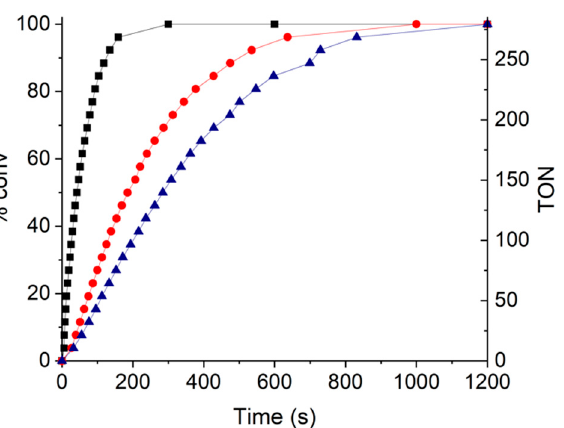
Figure 7. Percentage of H 2 O 2 decomposed overtime by a suspension of MSN-4a in water for the 1st run ( ■ ), 2nd run ( ● ) and 3rd run ( ▲ ).